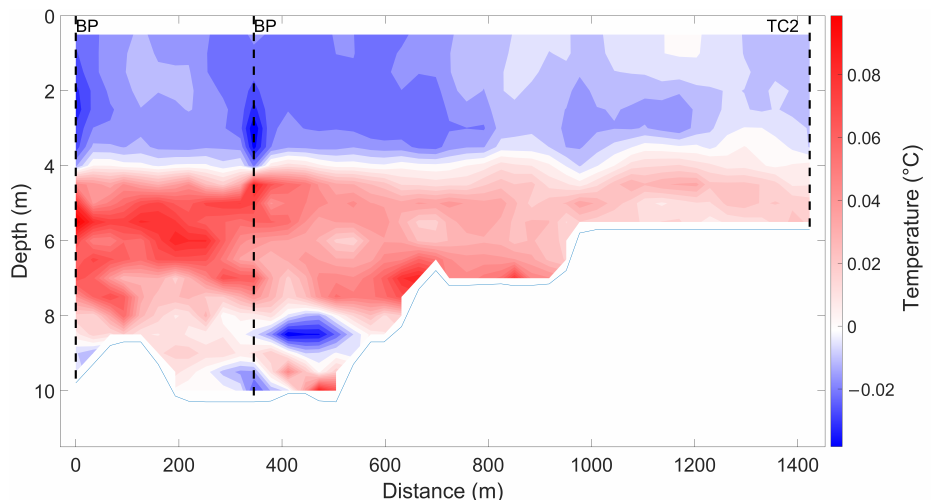
Figure 4. Differences in mean water temperature over the period of in situ observations between a run where the AEM3D bubble plume module is turned on and then off. Black dotted lines show the positions of bubble plumes and temperature chains. These were run for June in